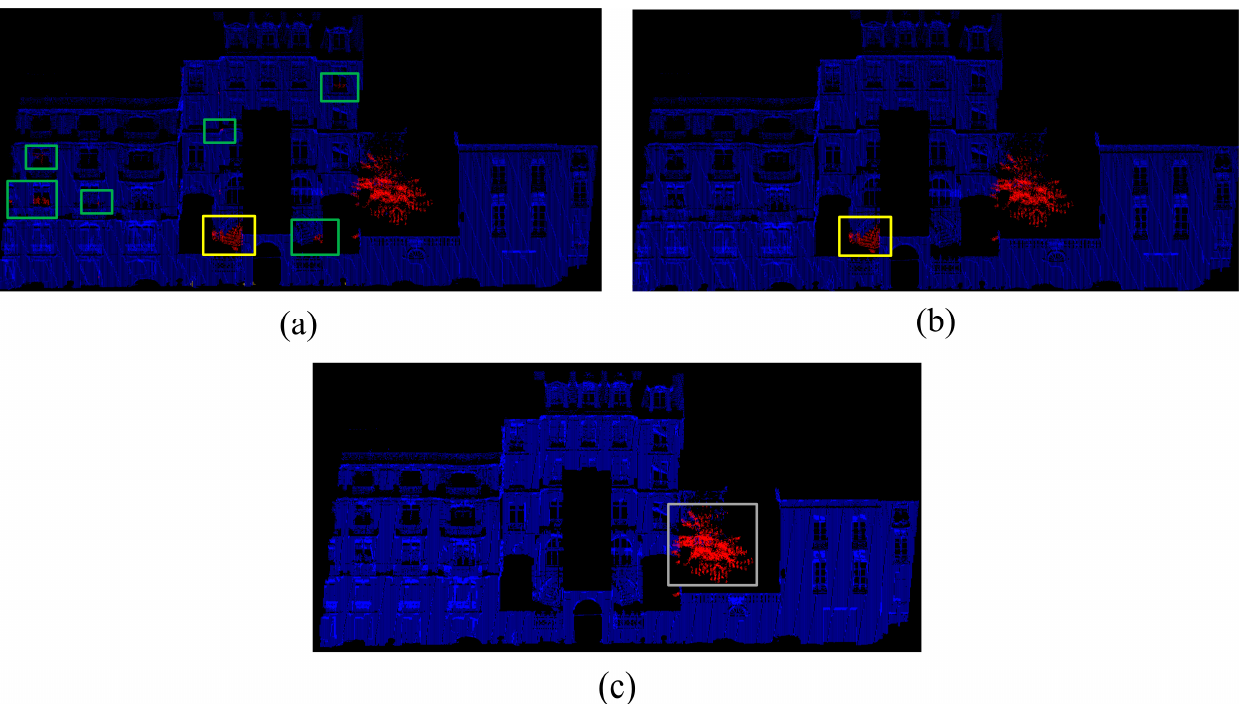
Figure 5. Illustration of small-label cluster optimization. ( a ) Results of a clique from higher-order CRF refinement. ( b ) Result of higher-order CRF with a small-label cluster when 𝑀 (cid:3049)(cid:3032)(cid:3034)(cid:3032)(cid:3047)(cid:3028)(cid:3047)(cid:3036)(cid:3042)(cid:3041) = 50. ( c ) Result of higher-order CRF with a small-label cluster when 𝑀 (cid:3049)(cid:3032)(cid:3034)(cid:3032)(cid:3047)(cid:3028)(cid:3047)(cid:3036)(cid:3042)(cid:3041) = 150.